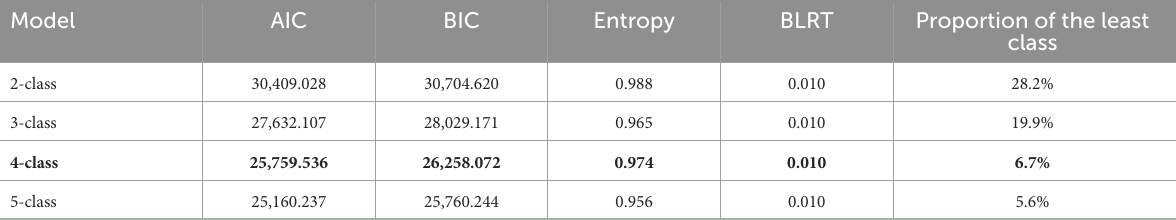
TABLE 2 Model fit indices of latent profile analysis of stress load ( n = 609).